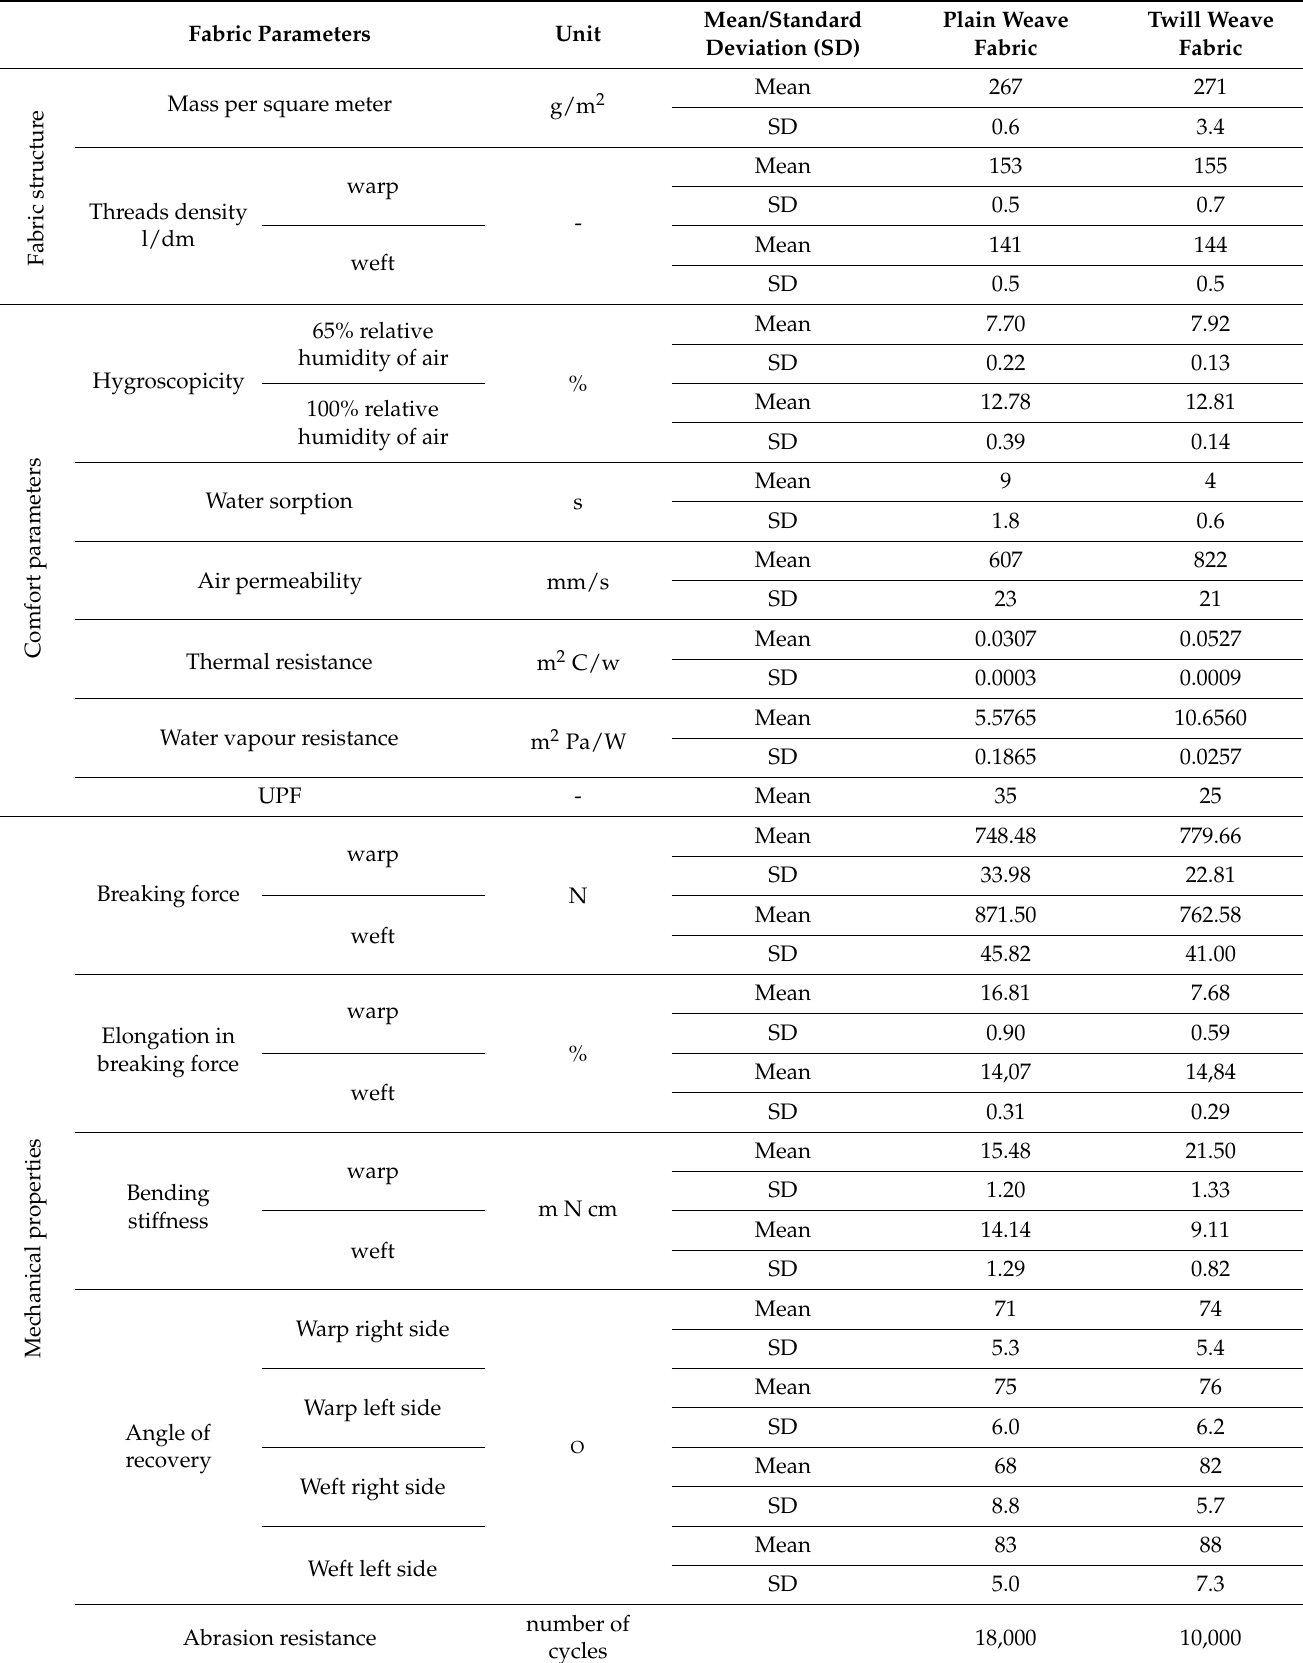
Table 4. Properties of pure hemp